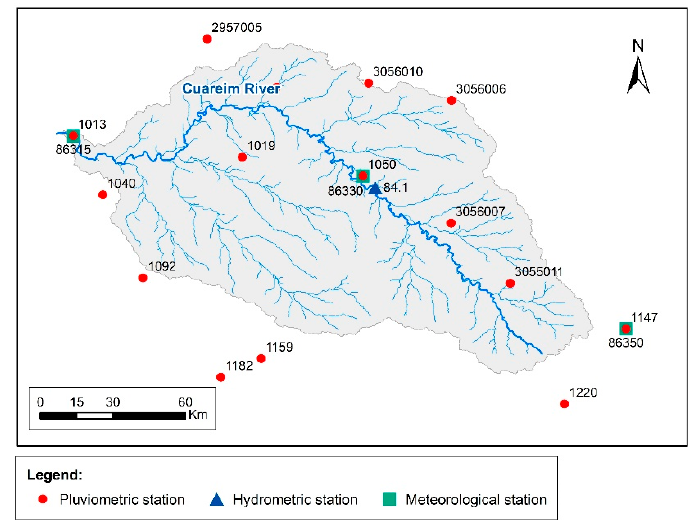
Figure 3. Location of pluviometric (red dots), hydrometric (blue triangle), and meteorological stations (green squares).